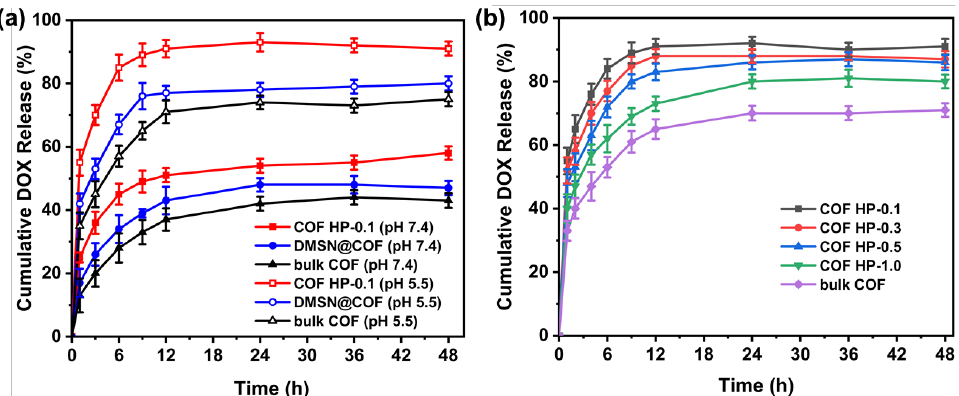
Figure 6. The DOX release profiles of bulk COF, DMSN@COF, and COF HP-0.1 in pH 5.5 and pH 7.4 solutions ( a ). The DOX release profiles of different series of COF HP (0.1, 0.3, 0.5, and 1.0) and bulk COF in the pH 5.5 solution ( b ).